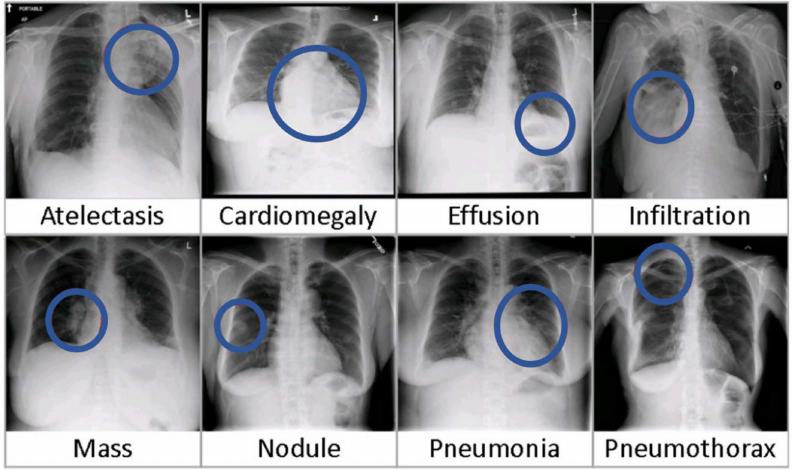
Figure 6. Illustration of Eight common thoracic diseases from